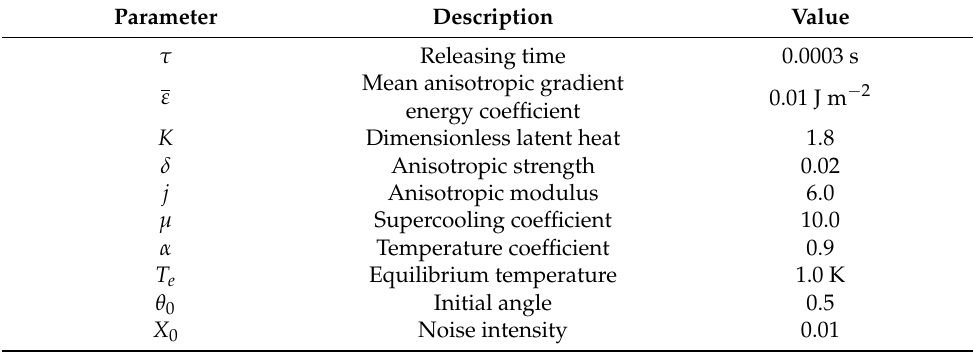
Table 1. PF parameters [17].